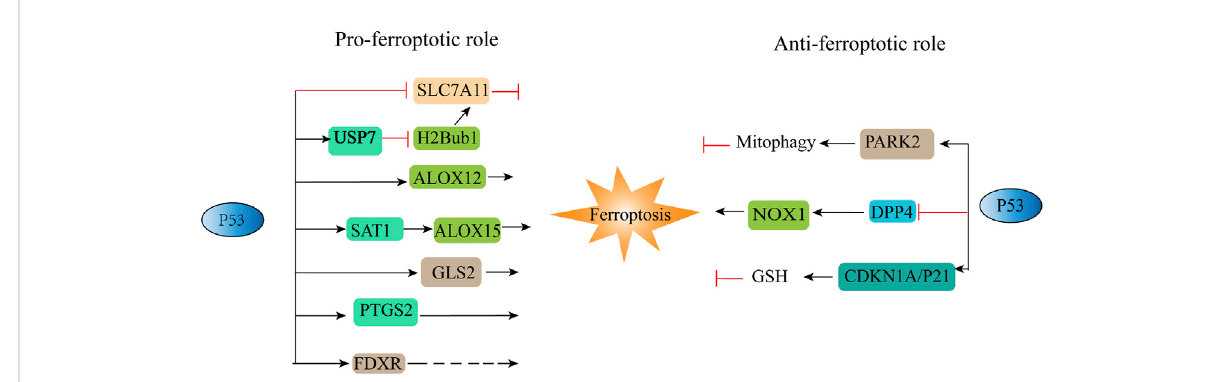
FIGURE 3 Positive and negative regulation of P53 to ferroptosis. ALOX12, arachidonic acid 12 lipoxygenases; ALOX15, arachidonic acid 15 lipoxygenases; CDKN1A/P21, cyclin-dependent kinase inhibitor; DPP4, dipeptidyl peptidase-4; FDXR, ferredoxin reductase; GLS2, glutaminases; PARK2, Parkinson disease 2; PTGS2, prostaglandin-endoperoxide synthase 2; SAT1, spermidine/spermine N1-acetyltransferase. “ ⊥ ” represents inhibition, “ → “ represents